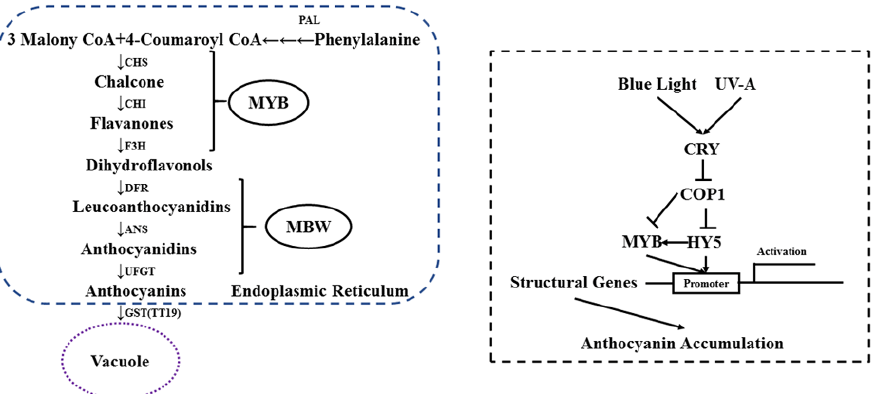
Figure 1. The pathway of anthocyanin biosynthesis and anthocyanin-related signal transduction induced by blue and UVA light.